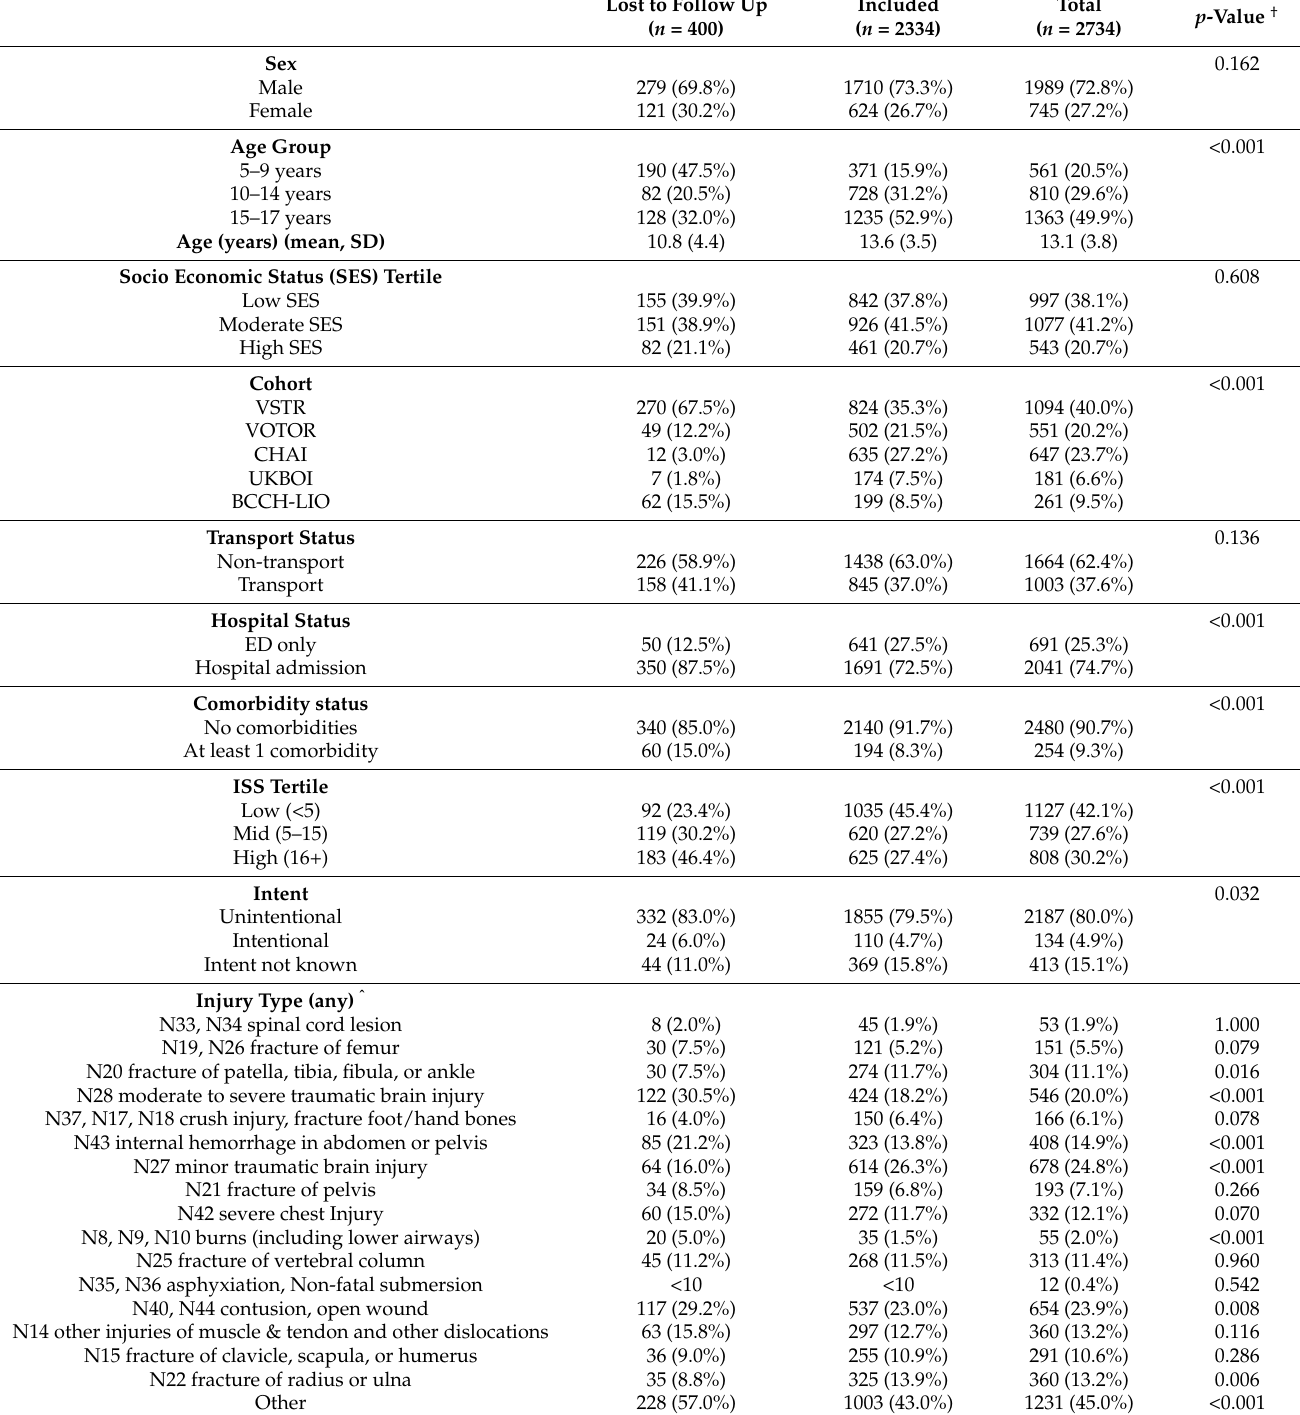
(Supplementary Table S2, Figure 1b), which was highest at 24 months. The proportion of children having problems with activity, pain and anxiety and depression rose by ≥ 1% between 12 months and 24 months. Table 2. VIBES-Junior pooled cohort characteristics included in analysis and lost to follow-up for EQ-5D ( n =